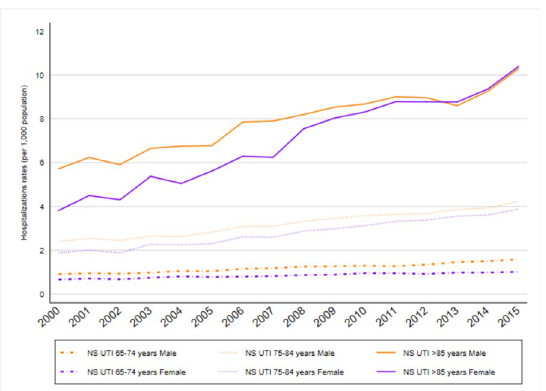
Fig 3. Non-specified UTIs. Non-specified UTIs hospitalization rates by sex and group of age (2000–2015).